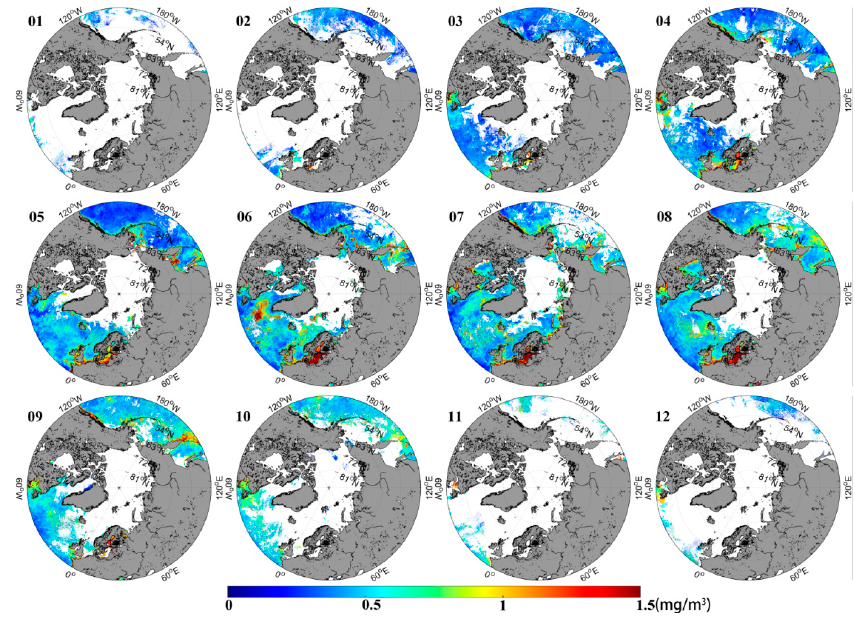
Figure 11 . Chlorophyll concentration retrieved from the monthly average Rrs products of HY-1C- COCTS calculated by the neural network algorithm .